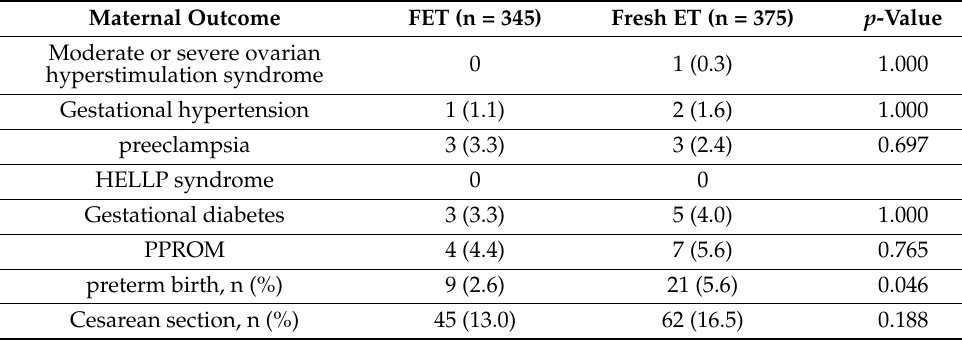
Table 4. Maternal outcomes of controlled ovarian